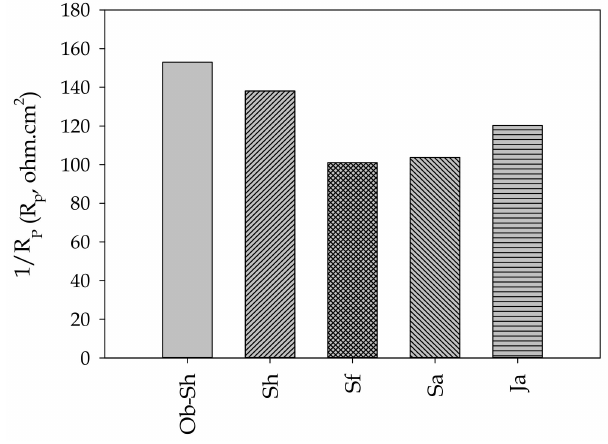
Figure 12. Variation in 1/R p for the studied Jeddah soil solutions.